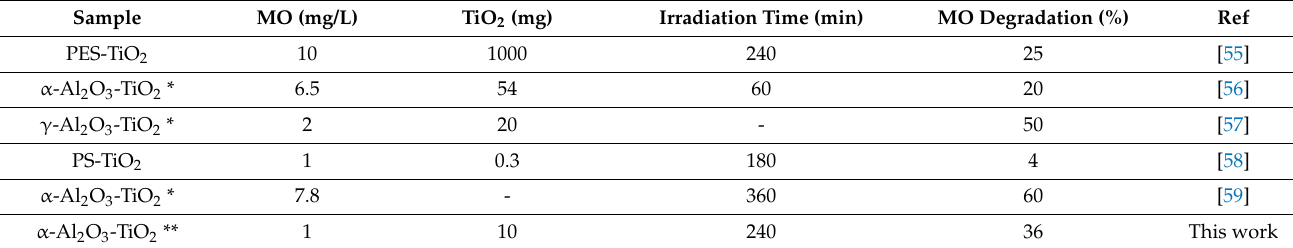
Table 5. Comparison with literature data.